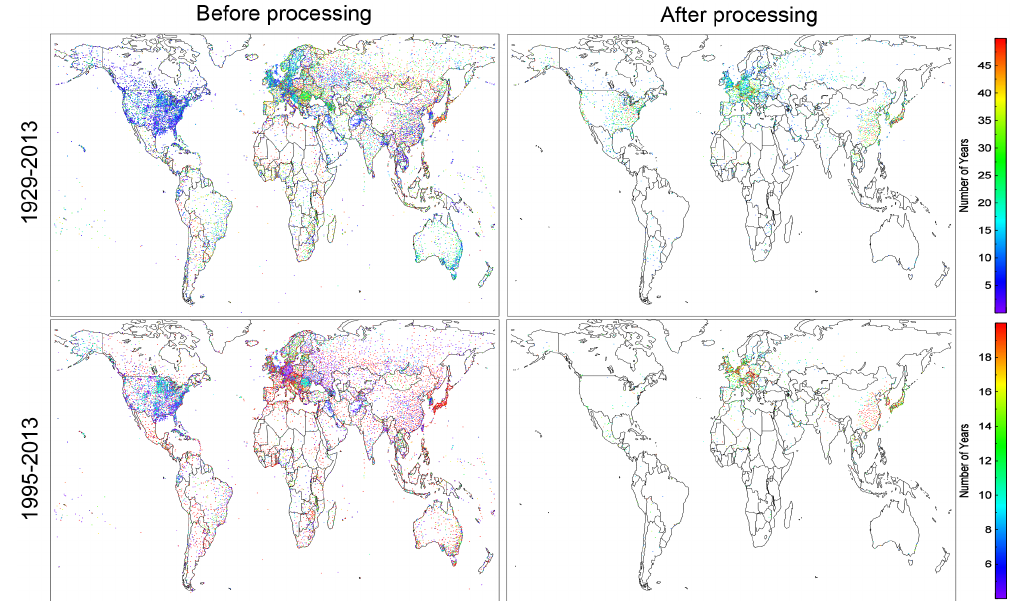
Figure 2. Distribution of Integrated Surface Database (ISD) stations before (left) and after (right) data screening. Colors indicate the number of years with available visibility data for (upper) 1929–2013 and (lower)